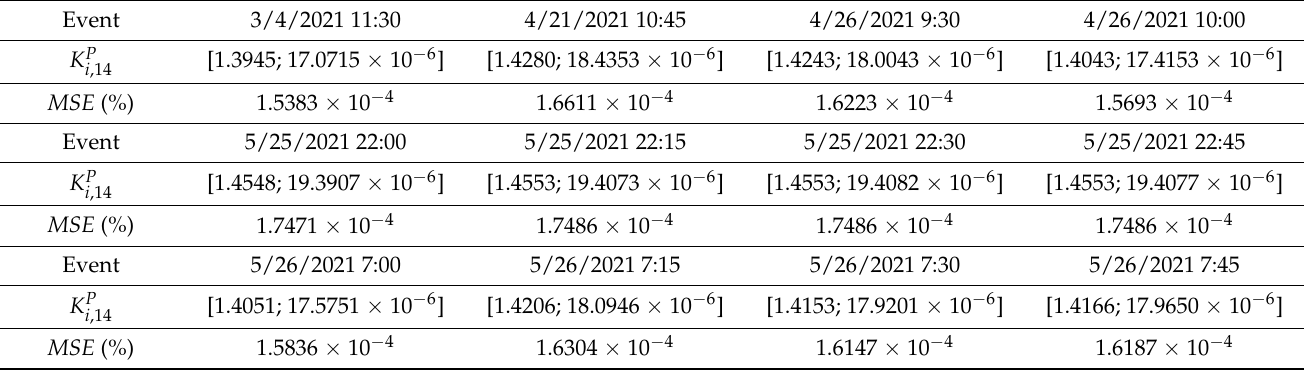
Table 2. Impact of change in active power consumption of a flexibility provider/asset on change in load of a congested line for different line congestion events.